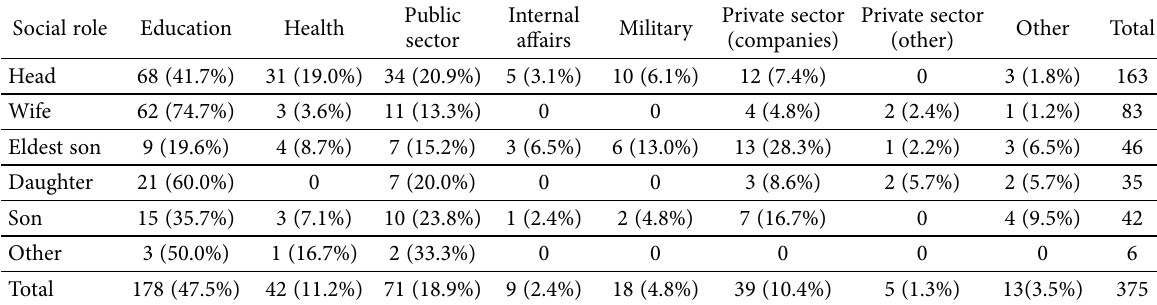
Table 2. Social role and place of work